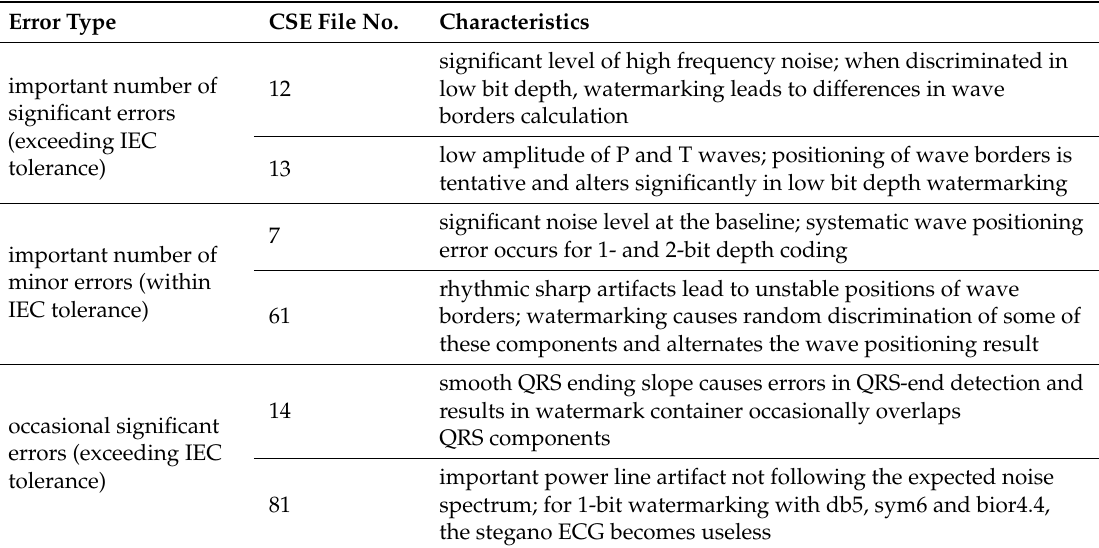
Table 6. Analysis of CSE files causing outlying results in the